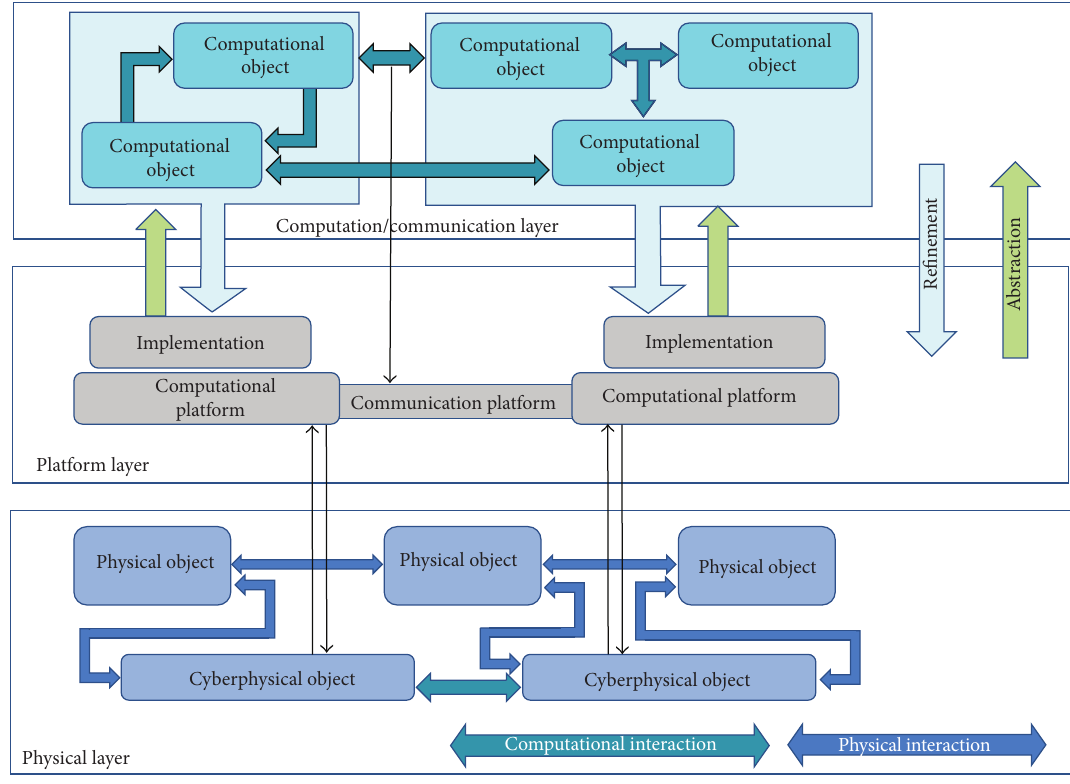
Figure 1: Design flow in CPS design layers